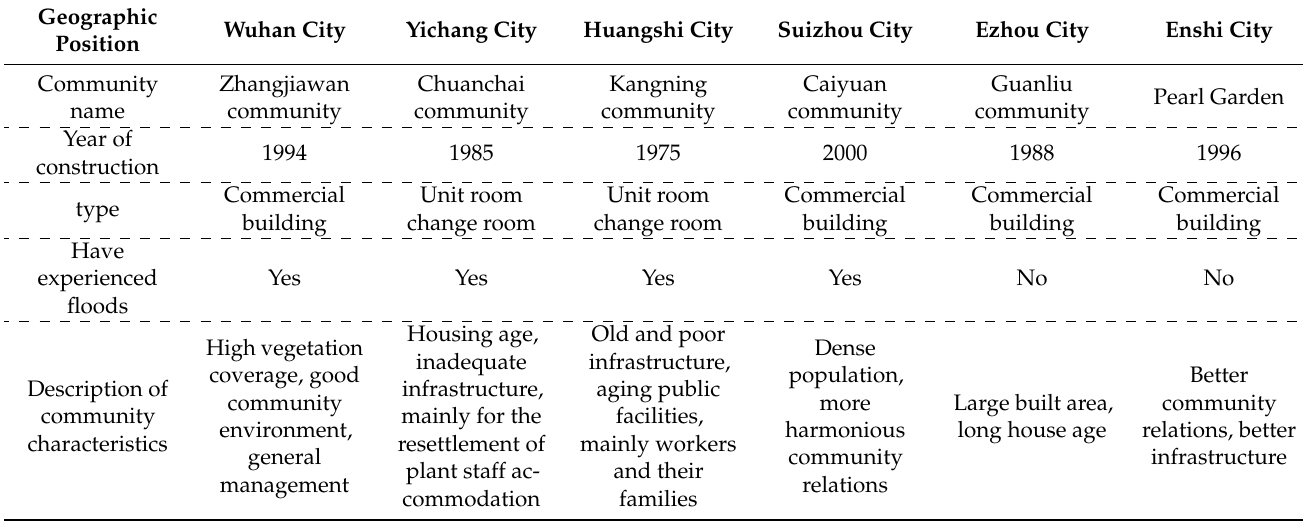
Table A3. Community